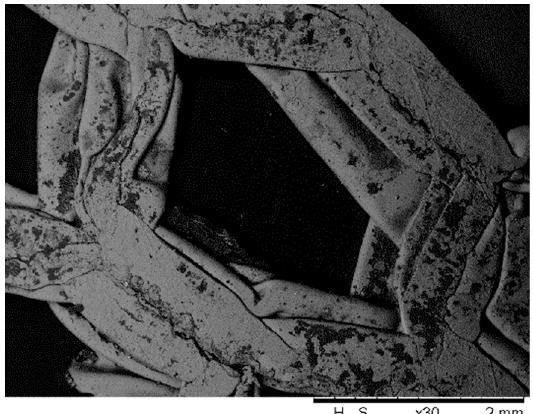
Figure 18. Electron micrograph of the cell structure after impact.